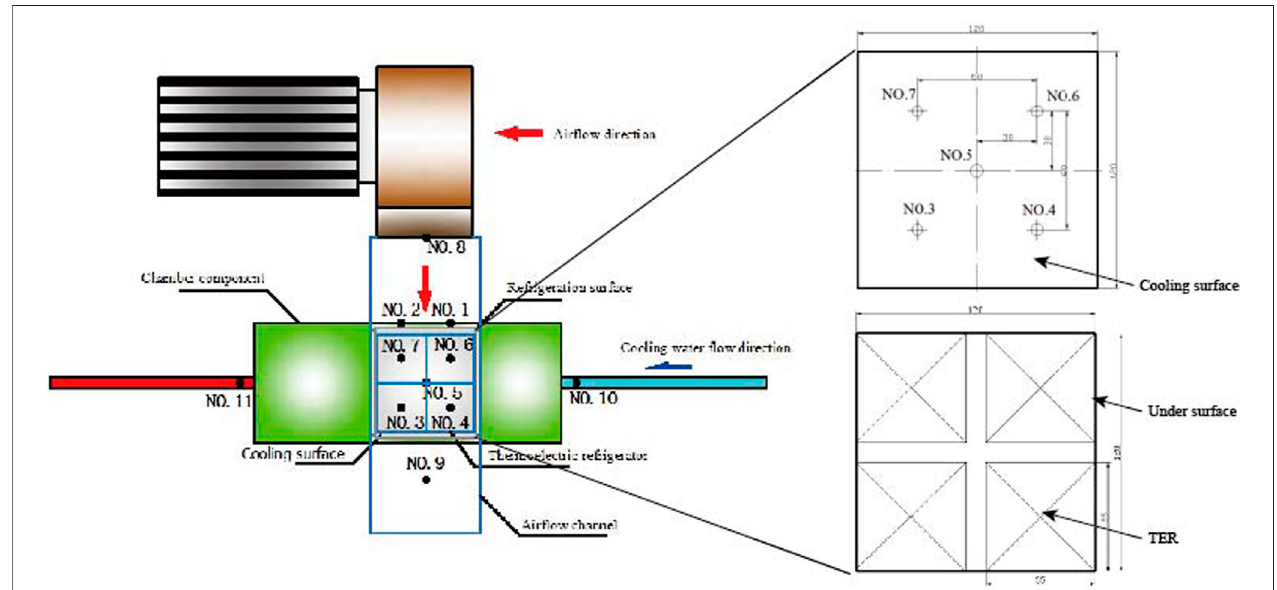
FIGURE 3 | Relative location of the thermocouple measurement point, unit